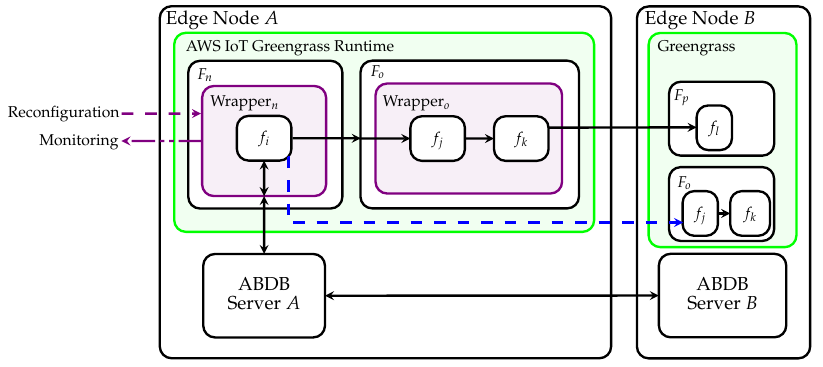
Figure 3. Simplified overview of application